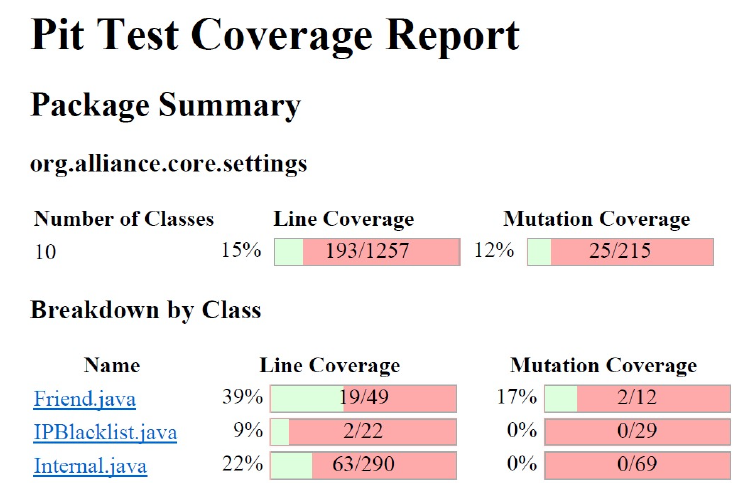
Figure 7. Example of a PIT